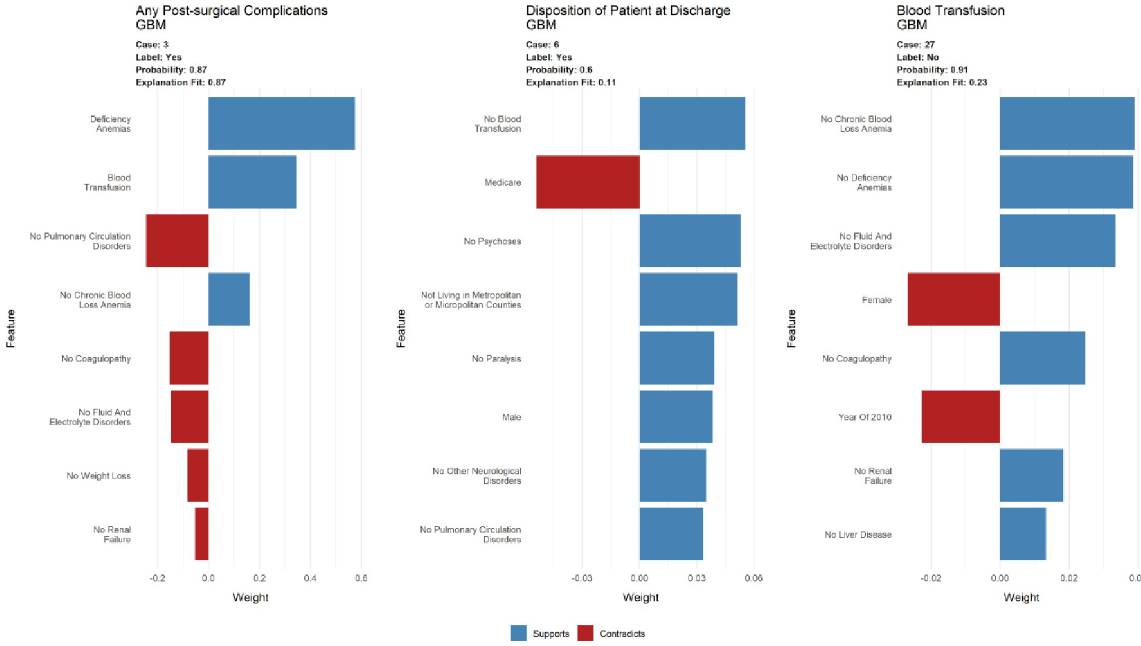
Fig 4. Diagrammatic representation of the patient-level predictions obtained using the GBM predictive